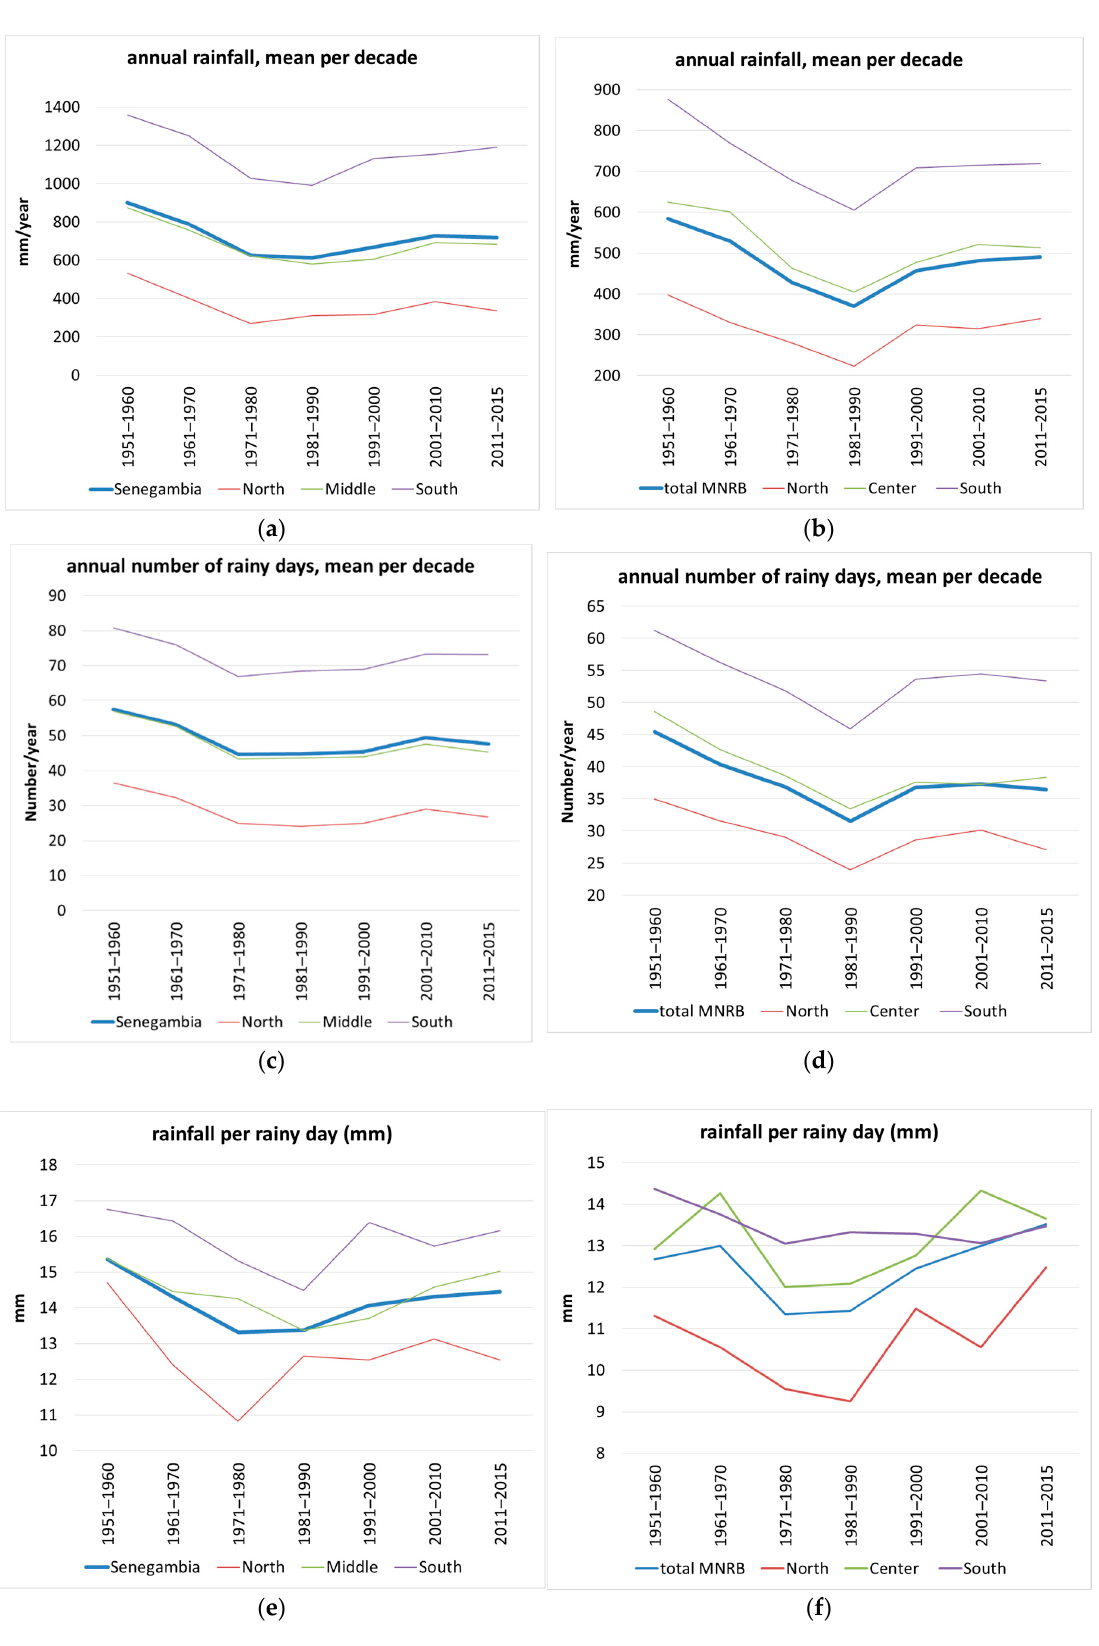
Figure 11. Decadal evolution of rainfall and number of events, and rainfall per event; data spatialized by Thiessen method; ( a , c and e ): Senegambia; ( b , d and f ): MNRB (see location in Figure 9). These observations could constitute the current trend, to be confirmed with new observations over the coming years.